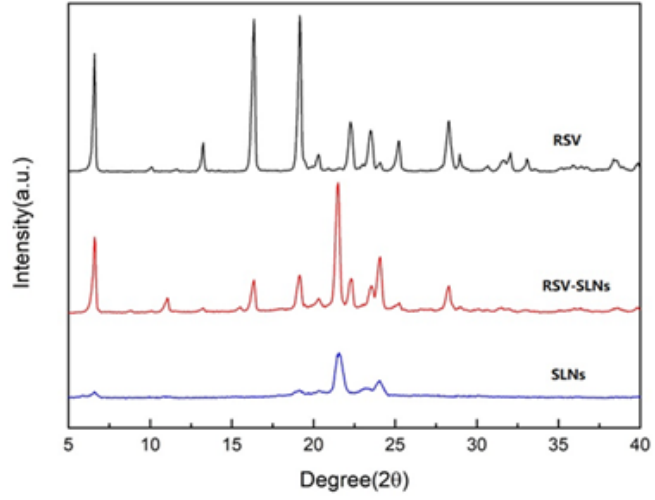
Figure 2. Powder X-ray diffraction patterns for RSV, RSV-SLN, and SLN.